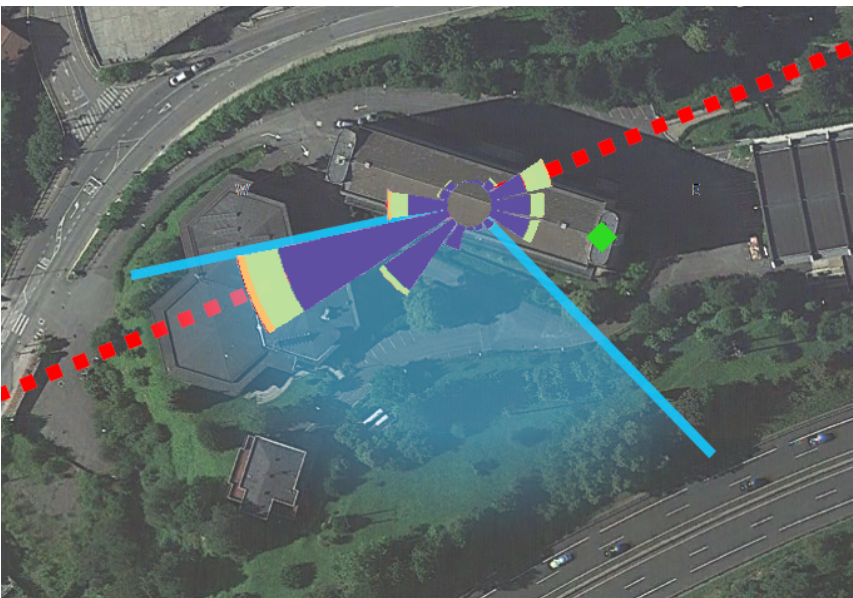
Figure 7. Representation of the studied building and the relevant information to choose a facade for the installation. The wind rose is the same of Figure 6. The light blue area corresponds to the absorption range of the selected facade. The dotted red line marks the valley’s direction. The green square marks the anemometer’s location on the